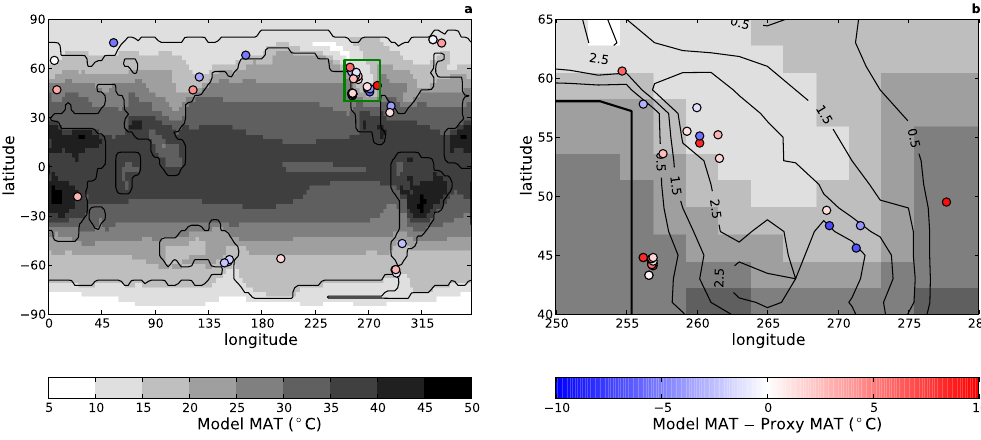
Fig. 5. Difference between modelled and reconstructed MAT as indicated by the color bar(on the right) overlain on the the model predicted temperatures (grey scale color bar on